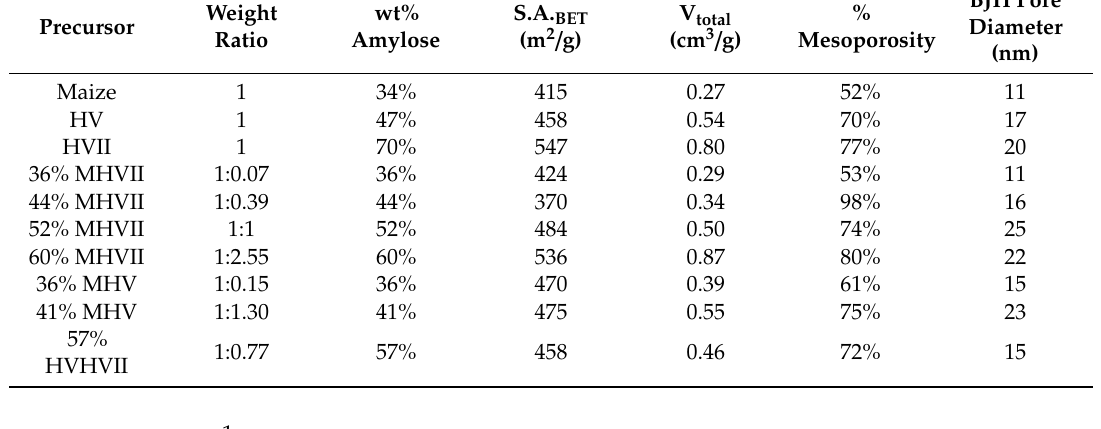
Table 2. Nanoporosity data of the prepared mesoporous carbons at 800 ◦ C.